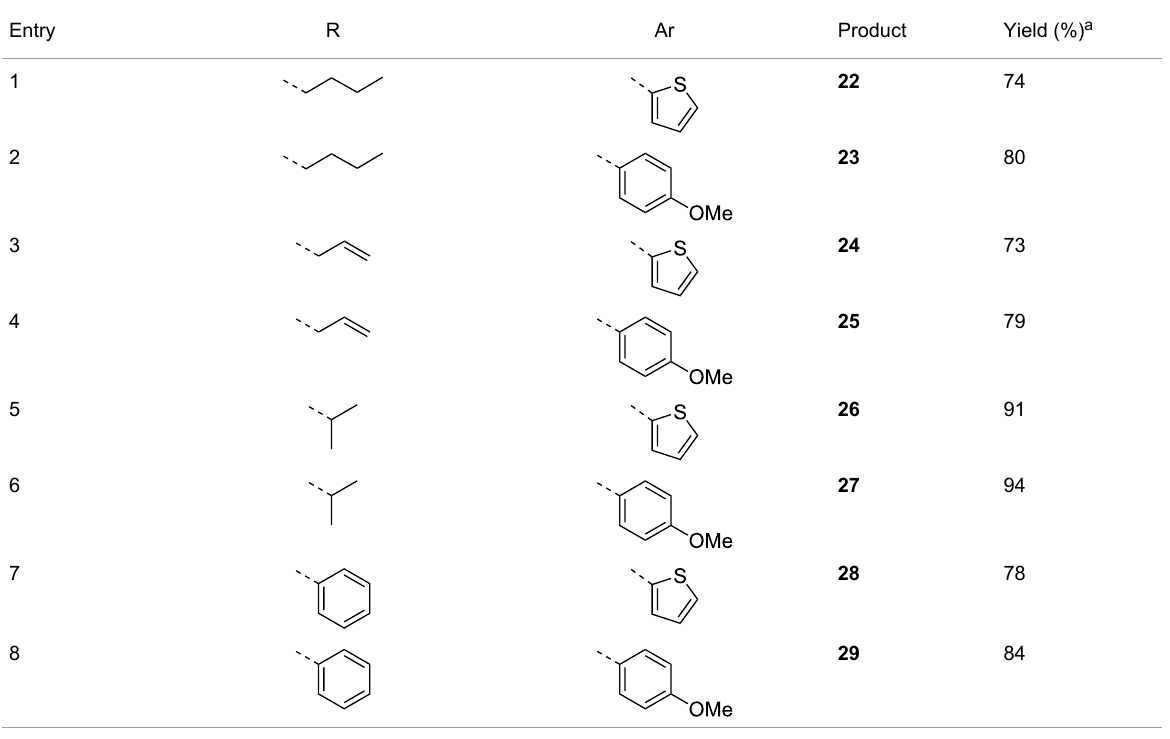
Table 5: Intramolecular inverse electron-demand Diels–Alder reactions of substituted alkynes 14–21 .